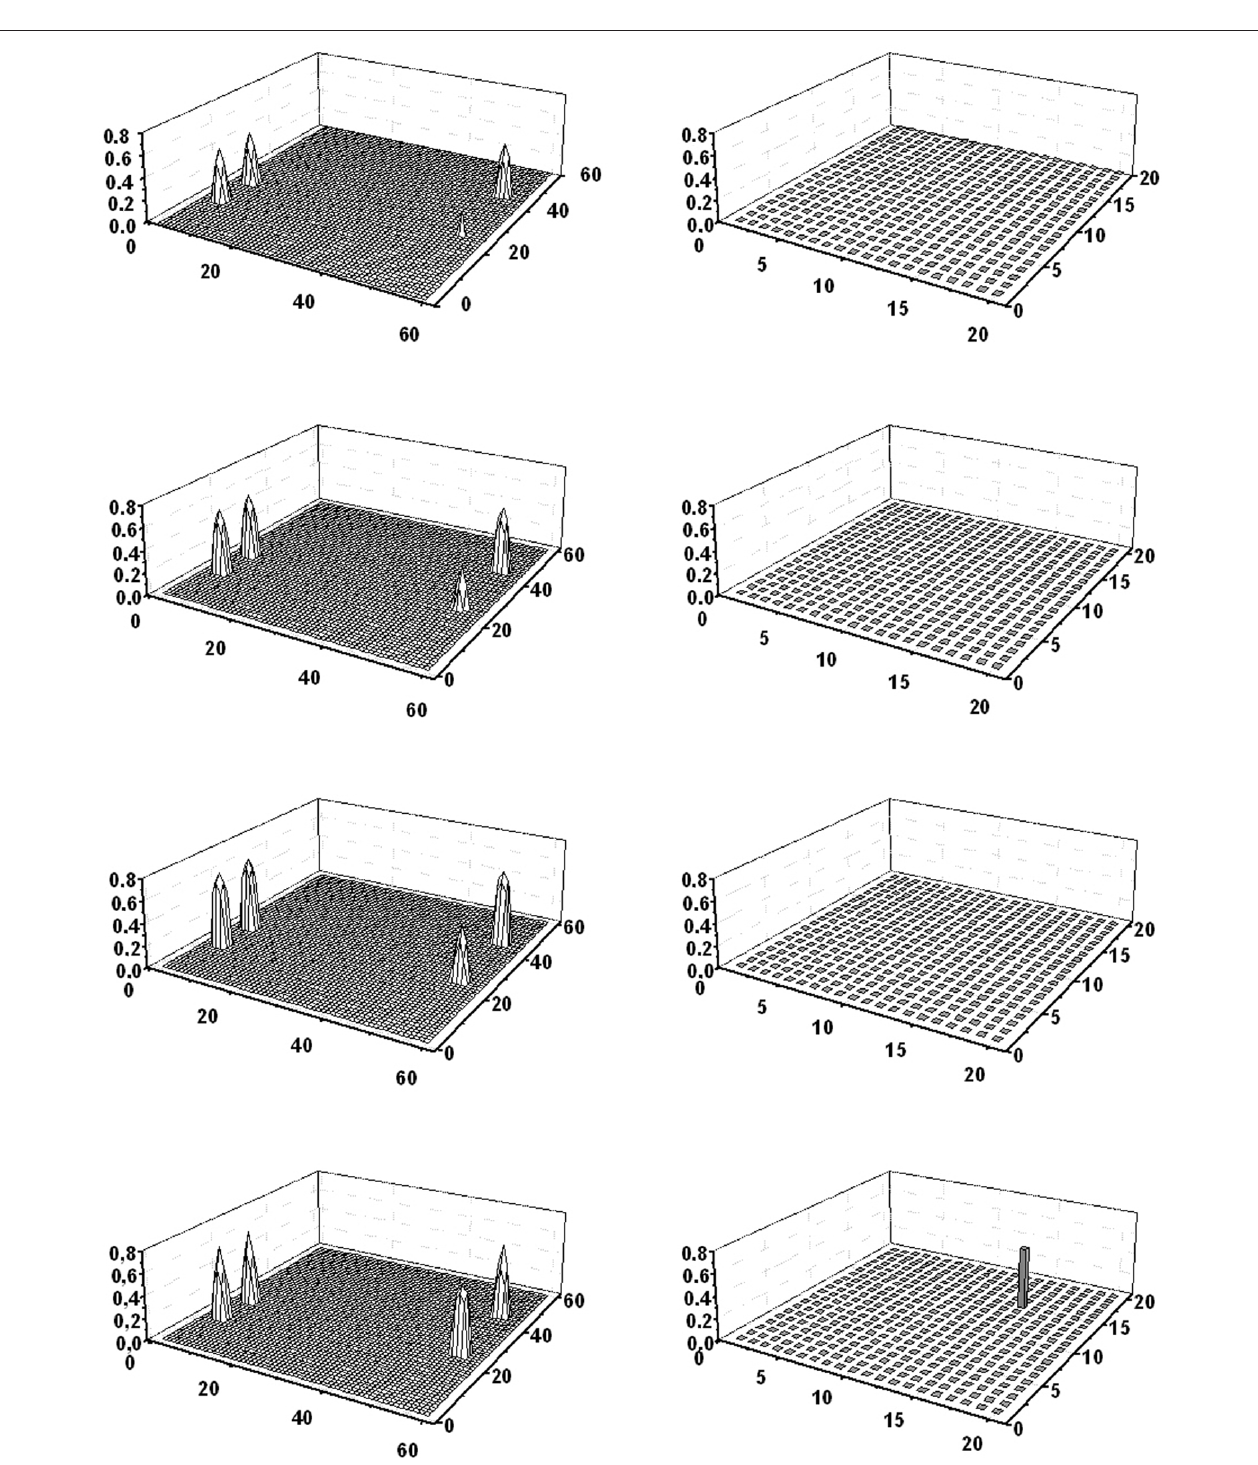
fourth common feature in the semantic network; when the overall conceptual representation of the category is reconstructed, the word coding for that category (“pet”) is activated in the lexical area (fourth line). It is worth noting that the distinctive properties of dog and cat are not evoked, and so individual members of the category do not appear in the lexical